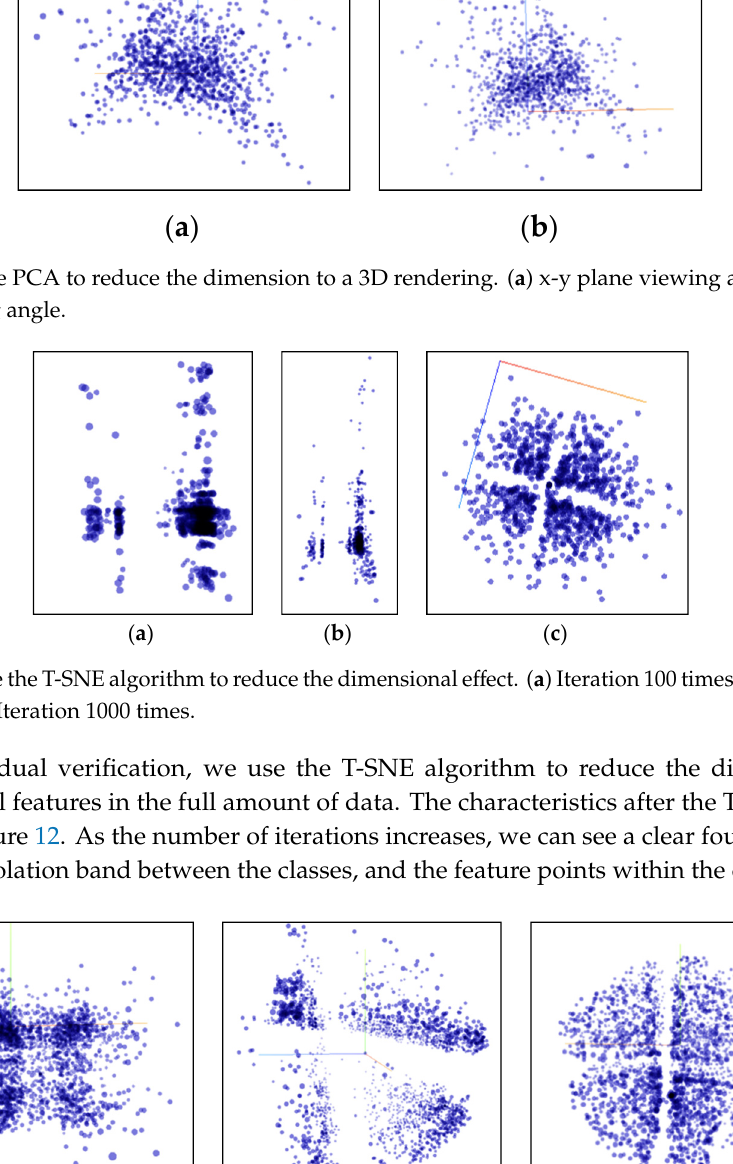
Figure 12. Full reduction of dimensions using the T-SNE algorithm. ( a ) Iteration 100 times; ( b ) Iteration 300 times; ( c ) Iteration 1000 times.